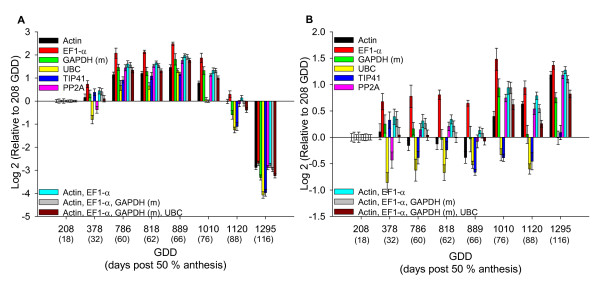
Expression levels of an aquaporin (A) and a sucrose transporter (B) during berry development. Genes were normalized to individual and/or combined reference genes. Developmental stages are defined by growing degree days (GDD), which are calculated by taking the average of the daily high and low temperature each day compared to a baseline (10°C). Data points are compared relative to the first sampling stage, 208 GDD. During the 2004 season, veraison, which is the period of berry ripening initiation, occurred between 786 and 889 GDD.